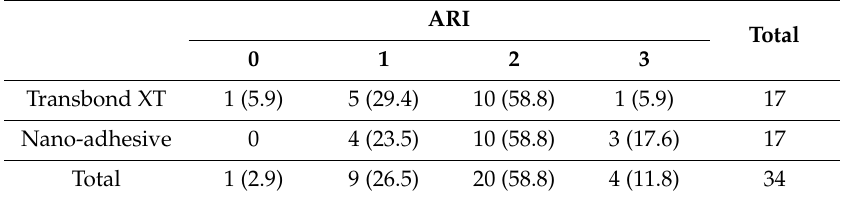
Table 1. The adhesive remnant index (ARI) scores on enamel tooth surfaces in 2 groups.